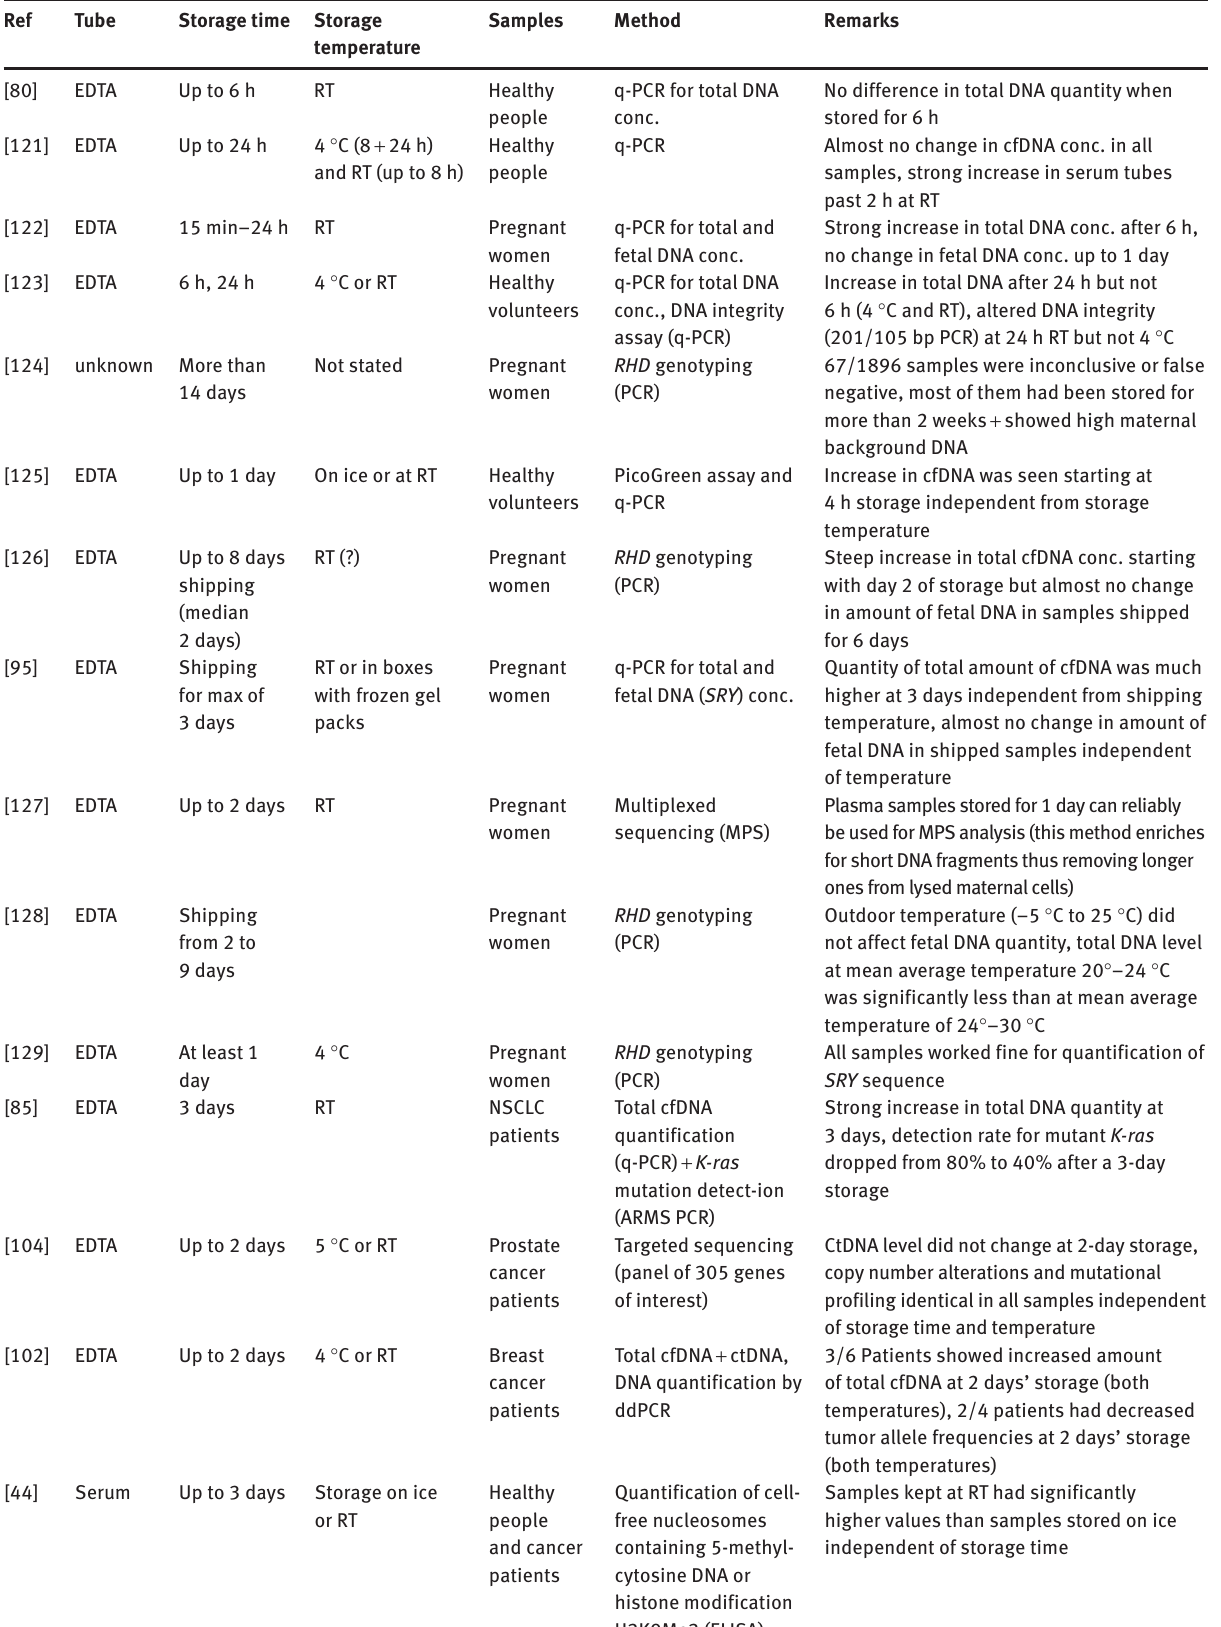
Table 5: Influence of delayed blood processing on cfDNA.